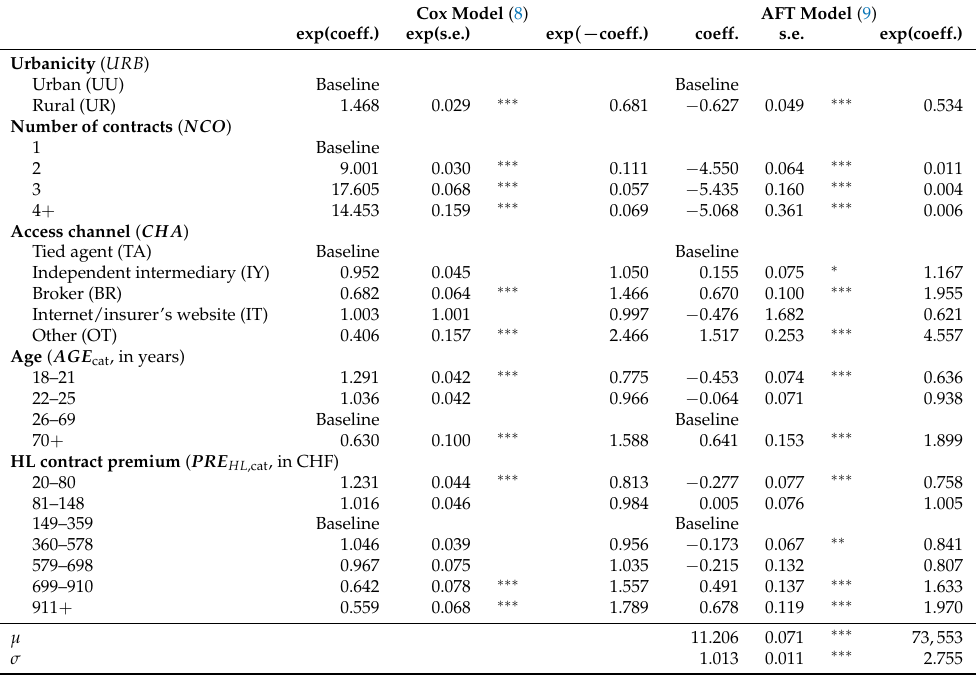
Table 6. Empirical results of the Cox and AFT models (8) and (9) for the HL cohort.